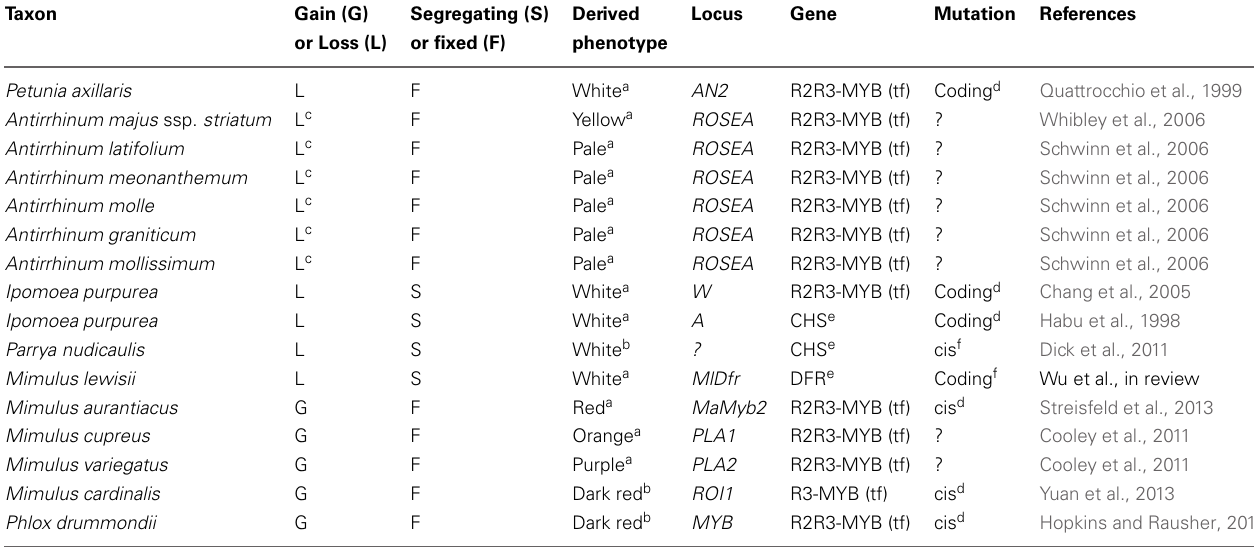
Table 1 | Species for which the genetic basis of altered floral pigment intensity have been characterized.